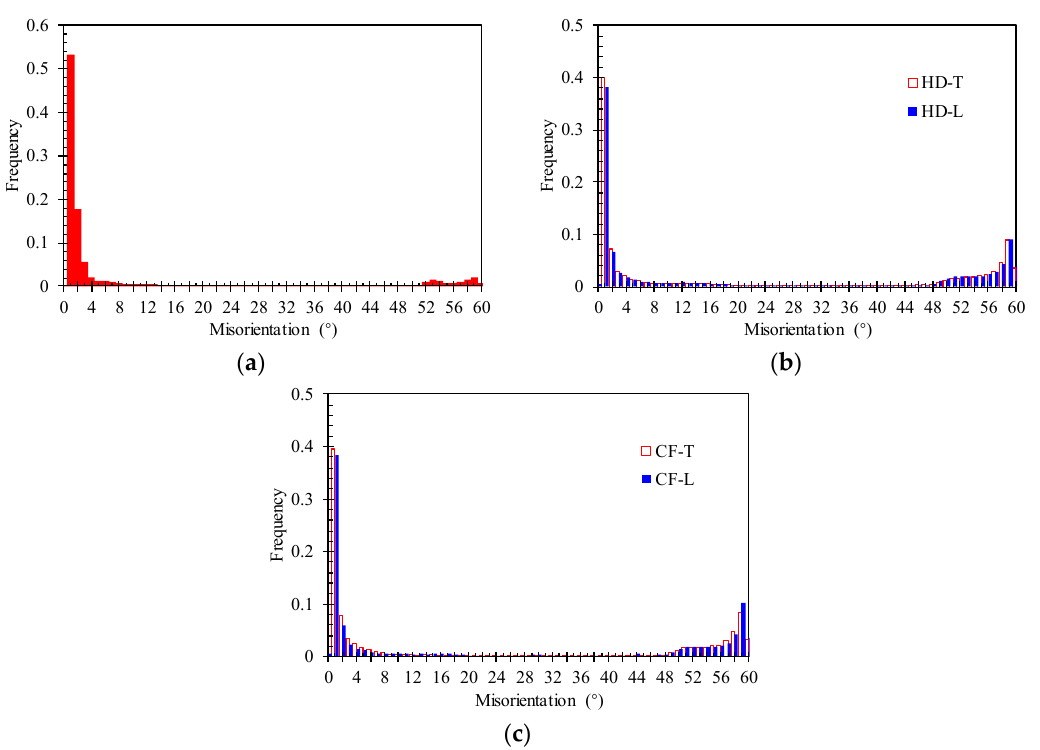
Figure 12. The misorientation distributions of grain boundaries for ( a ) BM, ( b ) HD, ( c ) CF. The local misorientation maps corresponding to materials with different processes are shown in Figure 13. It is clear that the residual strain is obviously larger in the BM than that in the HD and CF materials. The concentrations of residual strain frequently occurred at the grain boundaries in the BM. There is still a certain amount of grains with little residual strain adjacent to the grains with high residual strain in the BM.